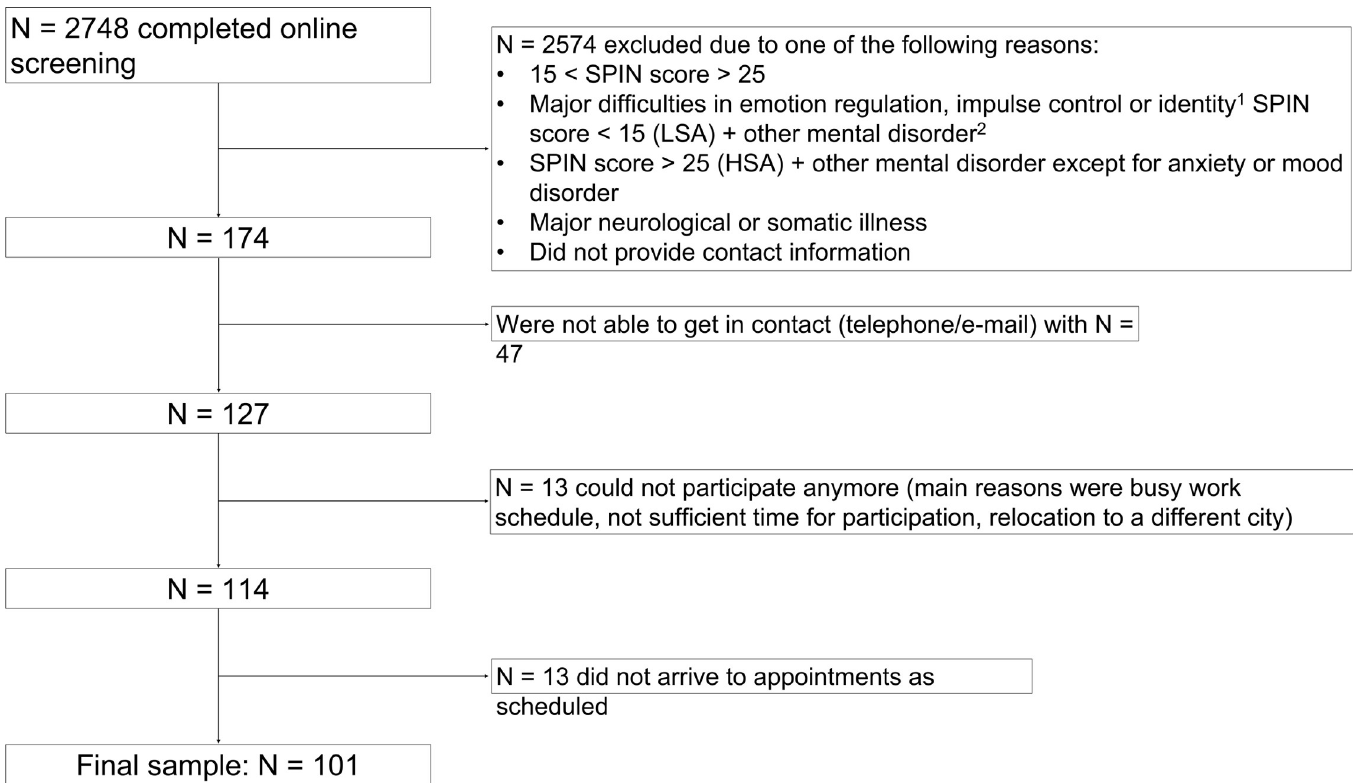
Fig 1. Flowchart of participant selection. 1 assessed by SCID-II items on borderline and antisocial personality disorder; 2 assessed by SCID-I screening items. SPIN = social phobia inventory; SCID = Structured Clinical Interview for DSM-IV; LSA = low social anxiety; HAS = high social anxiety.